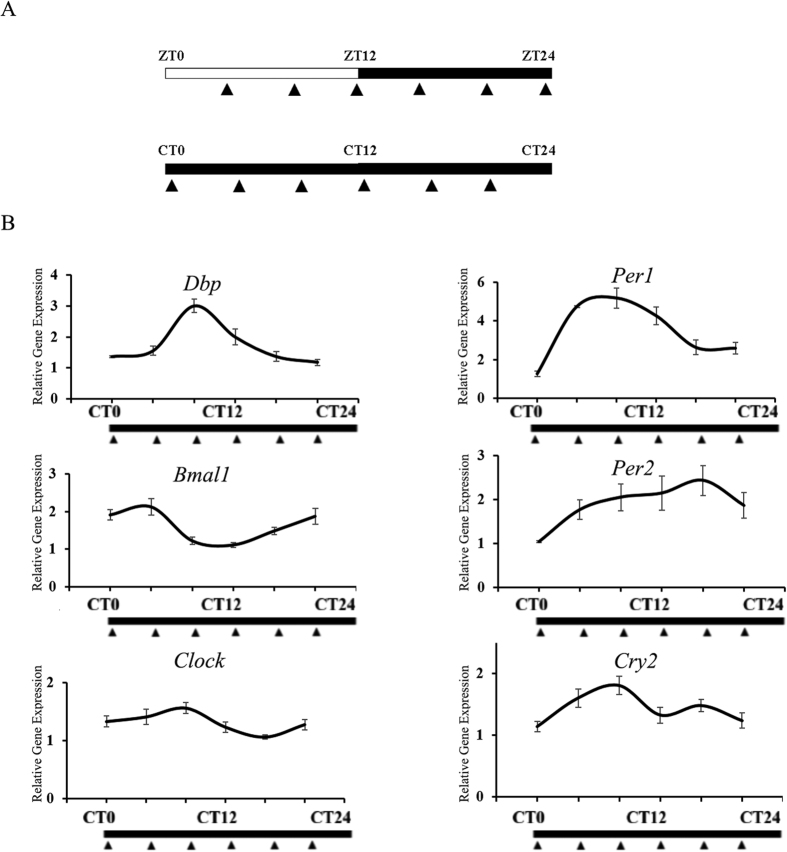
qPCR and JTK_CYCLE algorithm analysis of core clock gene in hippocampus.The qPCR results and the cycling parameters predicted by the JTK_CYCLE algorithm of core clock genes under the DD condition in the hippocampus. (A) Schedule for sampling in the LD and DD conditions. WT mice were decapitated at ZT4, 8, 12, 16, 20, and 24 under the LD condition or at CT0, 4, 8, 12, 16, and 20 under the DD condition; (B) Gene expression patterns of core clock genes in the hippocampus in the DD condition (Dbp, Bmal1, Per1, Per2, Clock, and Cry2). The qPCR primers used here are listed in Supplementary Tables 2 and 3.